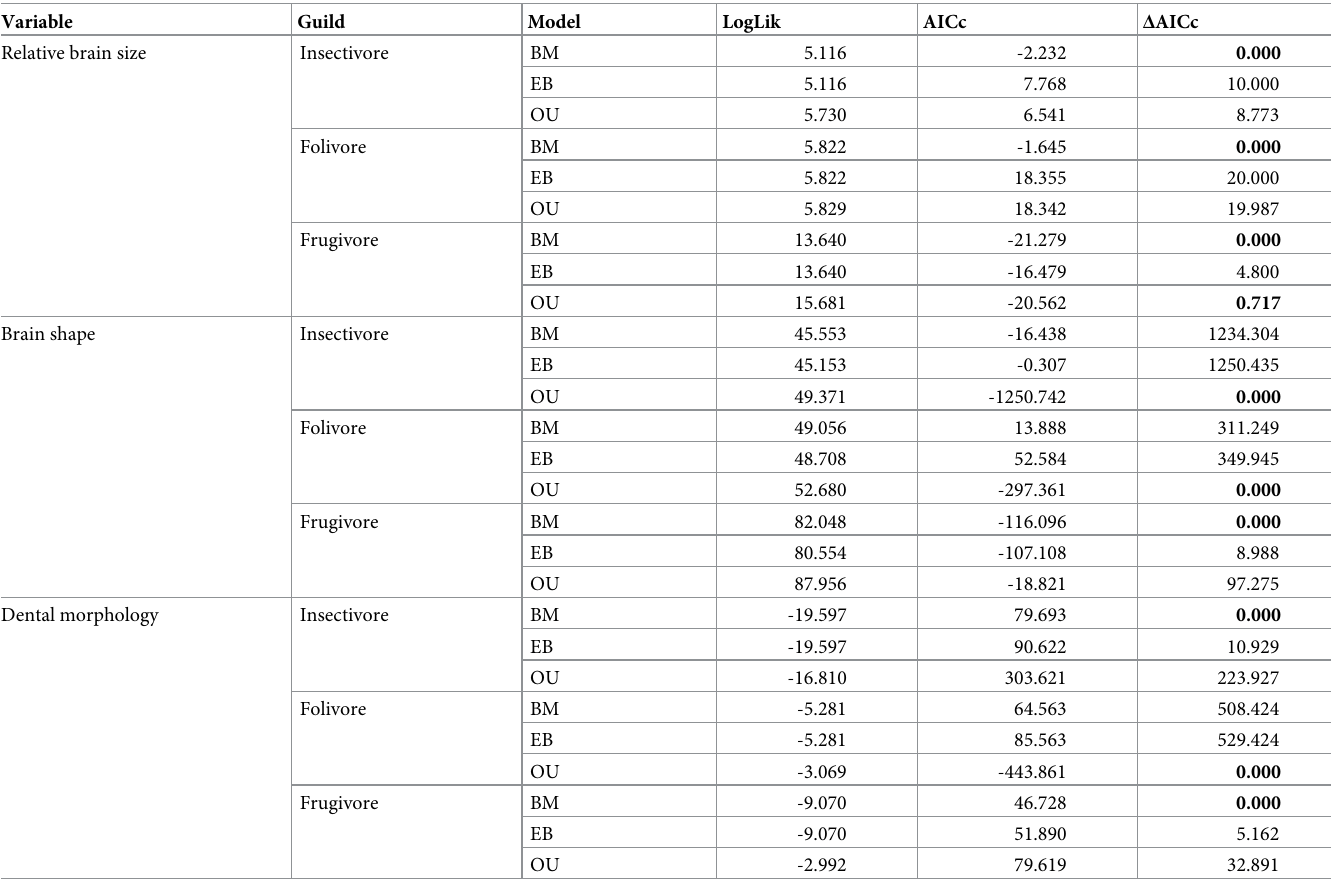
Table 5. Model fitting testing competing evolutionary hypotheses of phenotypic diversification across strepsirrhine dietary guilds. Three evolutionary models were tested: Brownian motion (BM), early burst (EB) and Ornstein-Uhlenbeck (OU). Models with Δ AICc lower than 2 were inferred as best